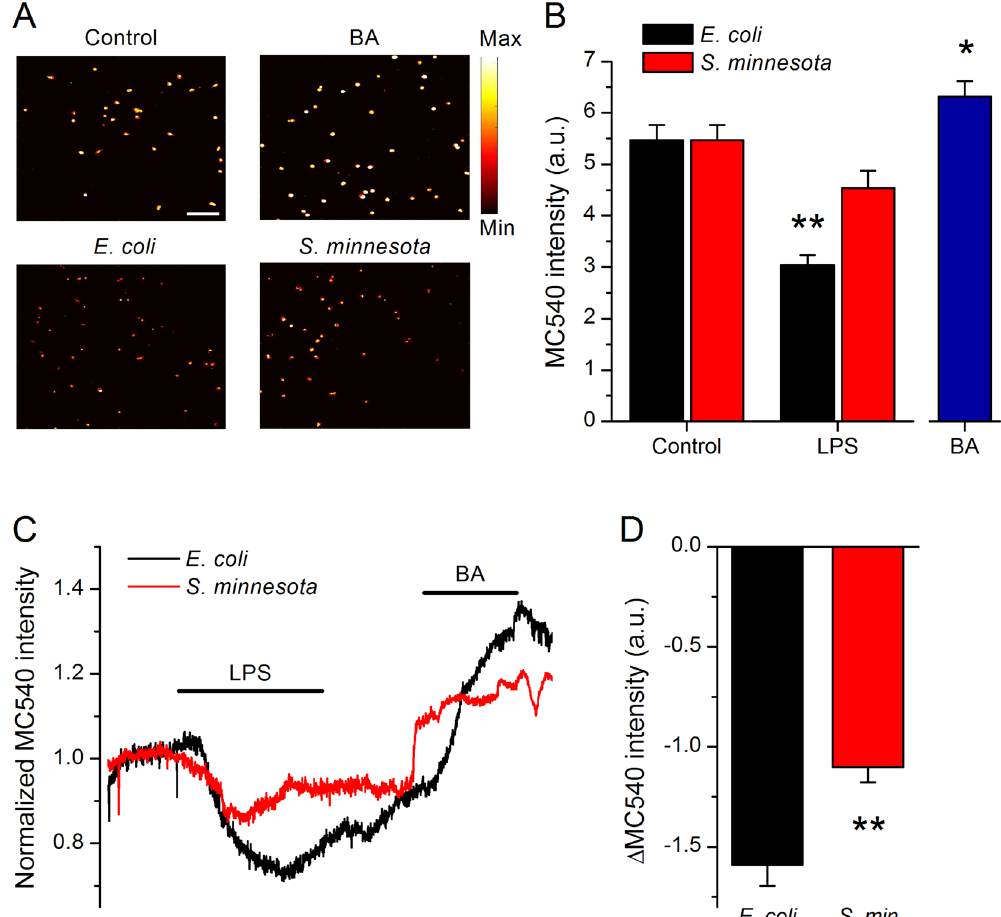
Figure 7. Changes in membrane MC540 fluorescence induced by LPS treatment. ( A ) Representative microscopic pseudo-colored images of HEK293T cells stained with MC540 (left, top panel) and pre-treated for 15 min with 125 mM BA (right, top panel) or 8 µ g/ml E . coli LPS or S . minnesota LPS (bottom panels). Scale bar, 150 µ m. ( B ) Average MC540 fluorescence intensity values obtained from determinations in the control, LPS or BA (n > 300). ( C ) Representative traces of MC540 fluorescence showing the effects of application of LPS from E . coli or S . minnesota . In both experiments, 125 mM BA was applied after LPS wash out. The horizontal lines indicate the duration of compound applications. ( D ) Average maximal changes in MC540 fluorescence intensity induced by E . coli (n = 40) and S . minnesota (n = 37) LPS. All recordings were conducted at 21 °C. * P < 0.05; ** P < 0.01, Mann-Whitney U